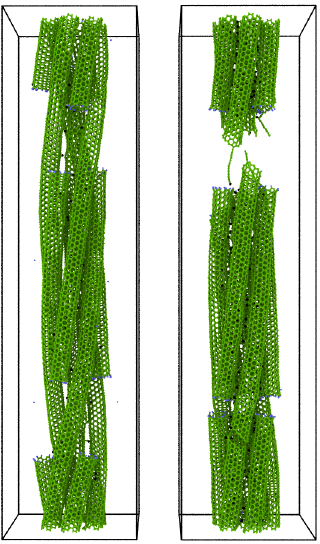
Figure 9. Snapshot at 15% strain of the 120° twisted bundle composed of 20 nm ( 6,6 ) CNTs for a percentage of linkers of 0.58% ( left ) and 1.53% ( right ). A different percentage of linkers corresponds to different failure mechanisms: the slipping of the nanotubes ( left ) and the fracture of the nanotubes ( right ),